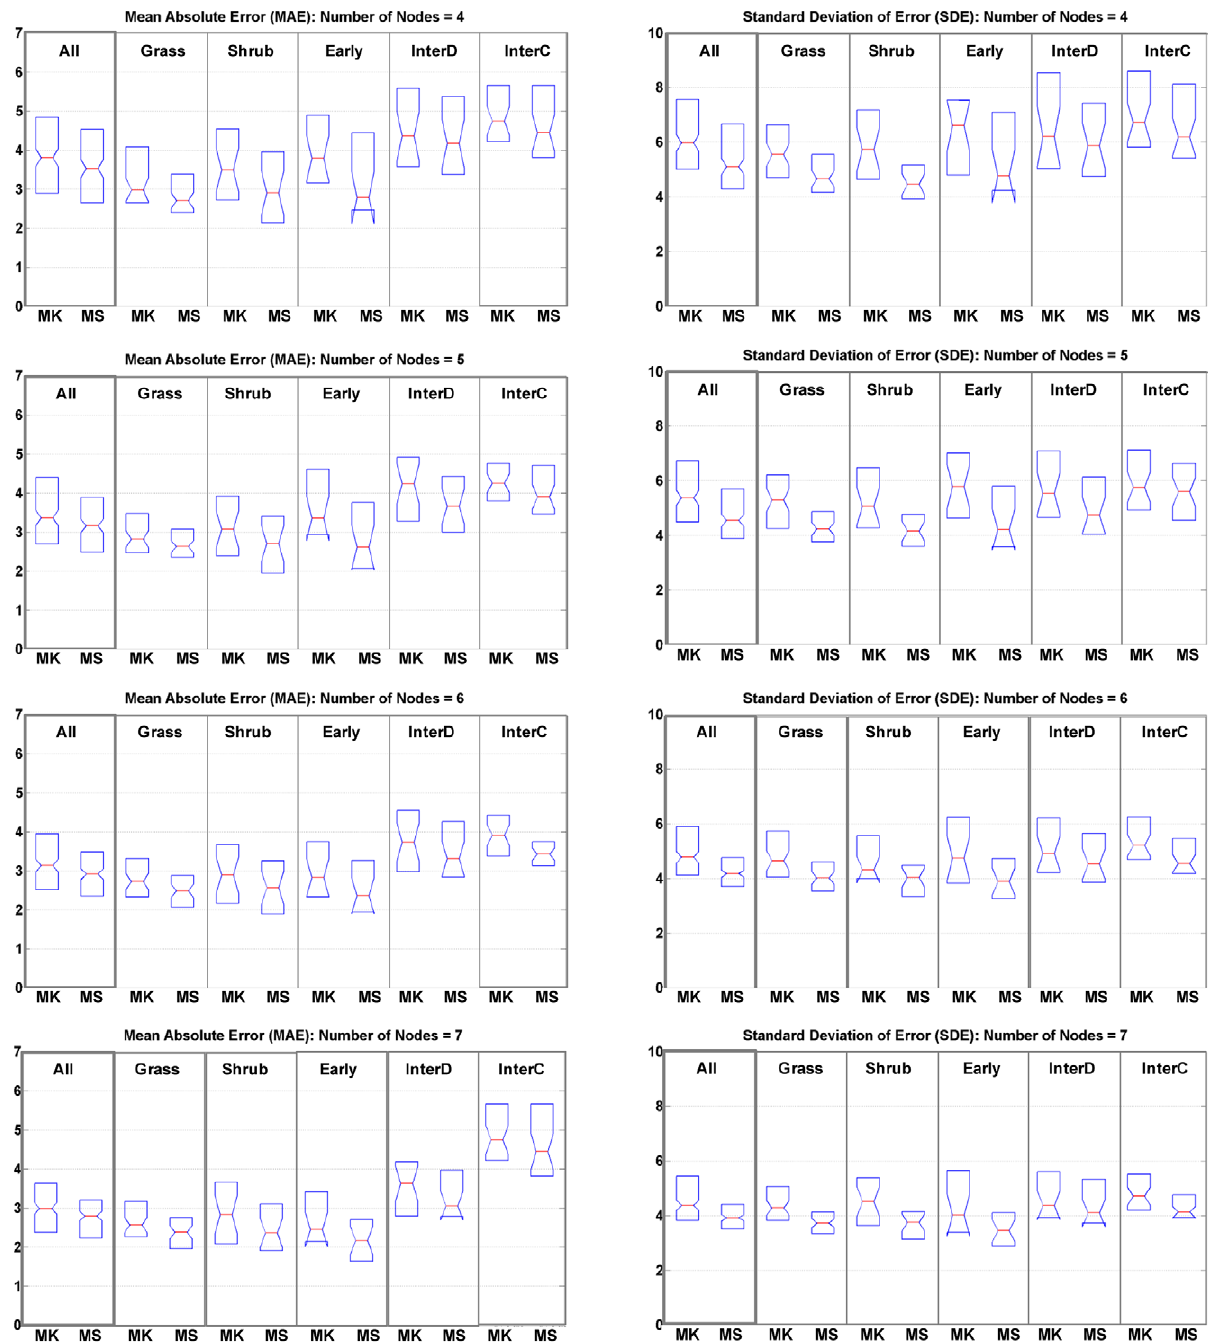
Figure 8. Comparison of MAE and SDE metrics for MK and MS RBFs.